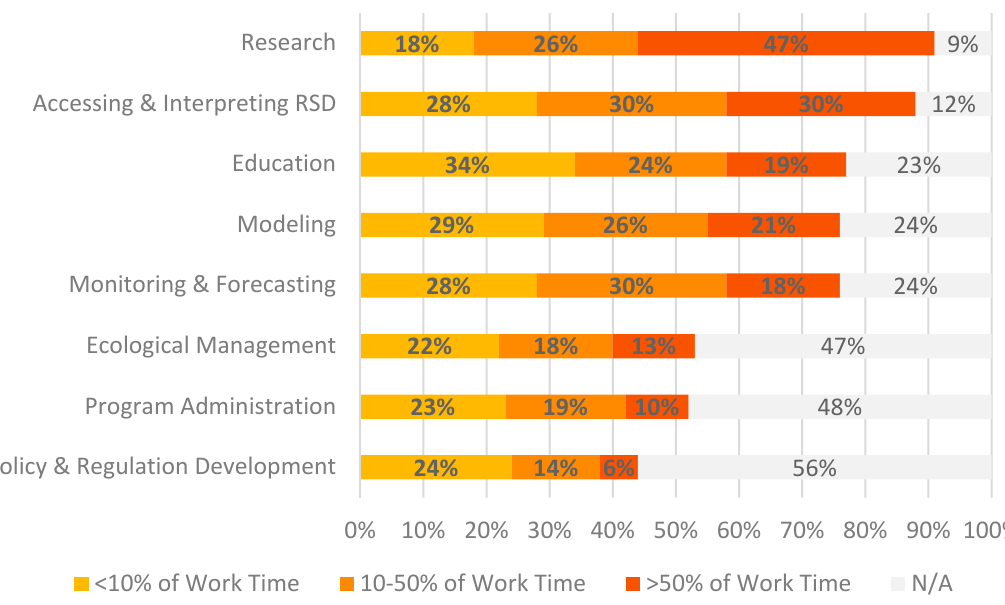
Figure 3. Proportion of work time devoted to various work tasks by all respondents. The gray portion on each bar represents the proportion of respondents for whom this task was not a responsibility ( N = 979).